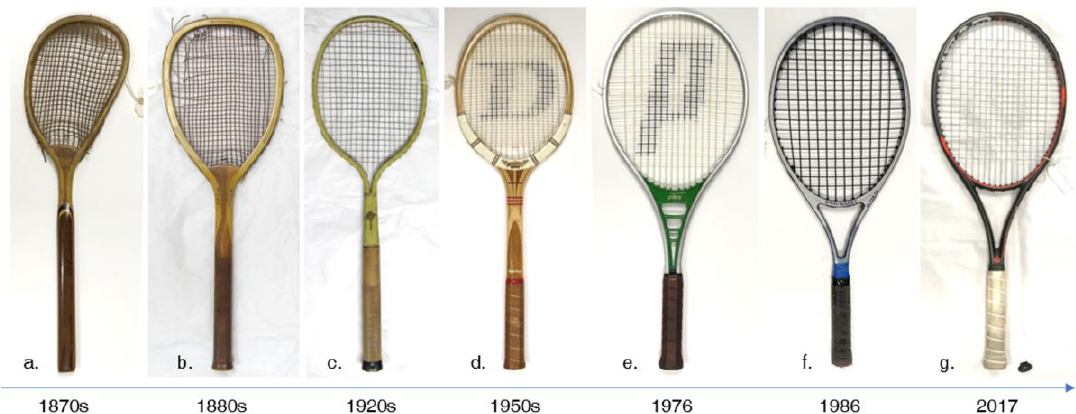
Figure 9. Seven tennis rackets showing developments over time: ( a ) Early racket by F. H. Ayres (1870s); ( b ) wooden racket by F. H. Ayres (1886); ( c ) steel racket by Dayton Steel Racket Corporation (1922); ( d ) Dunlop “Maxply” (1955); ( e ) Prince “Classic” (1976); ( f ) Snauwaert Hi-Ten 50 (1986); ( g ) Head Graphene XT Prestige with the sensor (2017).